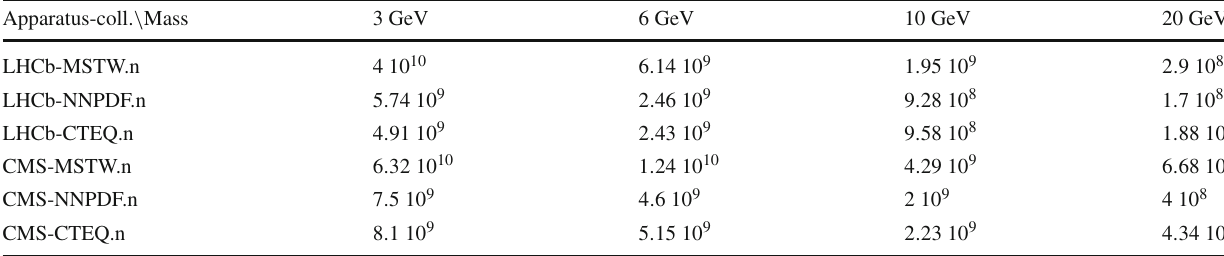
Table 1 Gluon–gluon luminosity table in picobarns as explained in the text below Apparatus-coll. \ Mass 3 GeV 6 GeV 10 GeV 20 GeV LHCb-MSTW.n LHCb-NNPDF.n LHCb-CTEQ.n CMS-MSTW.n